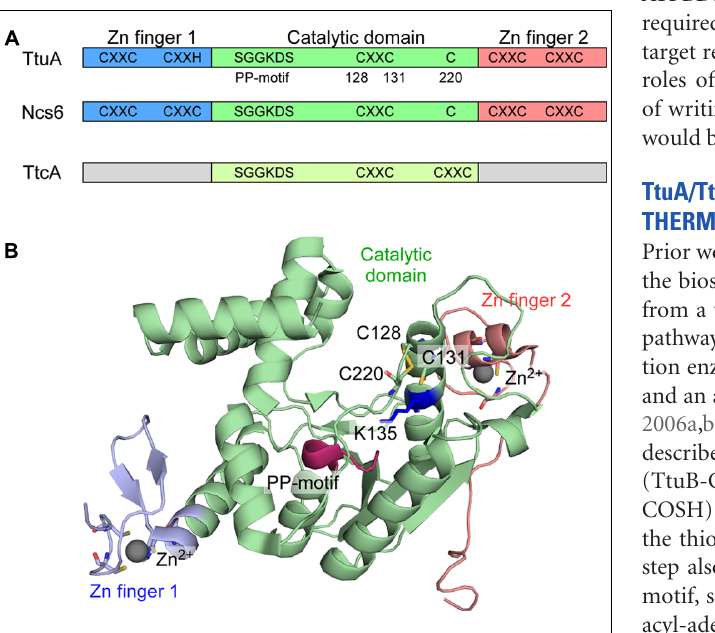
FIGURE 4 |TtuA and Ncs6 proteins in 2-thiouridine biosynthesis. (A) Schematic representation ofTtcA family proteins.TtuA and Ncs6 belong to group II of theTtcA family.TtuA is composed of two Zn finger domains and a catalytic domain.TtcA is responsible for the formation of 2-thiocytidine34. (B) Structure of P. horikoshii TtuA.The three domains are colored the same as in (A) .The PP-motif is shown in red.Three Cys residues that is important for enzyme activity is shown with a stick representation.The target K135 forTtuB conjugation (K137 in T. thermophilus ) is shown in a blue stick